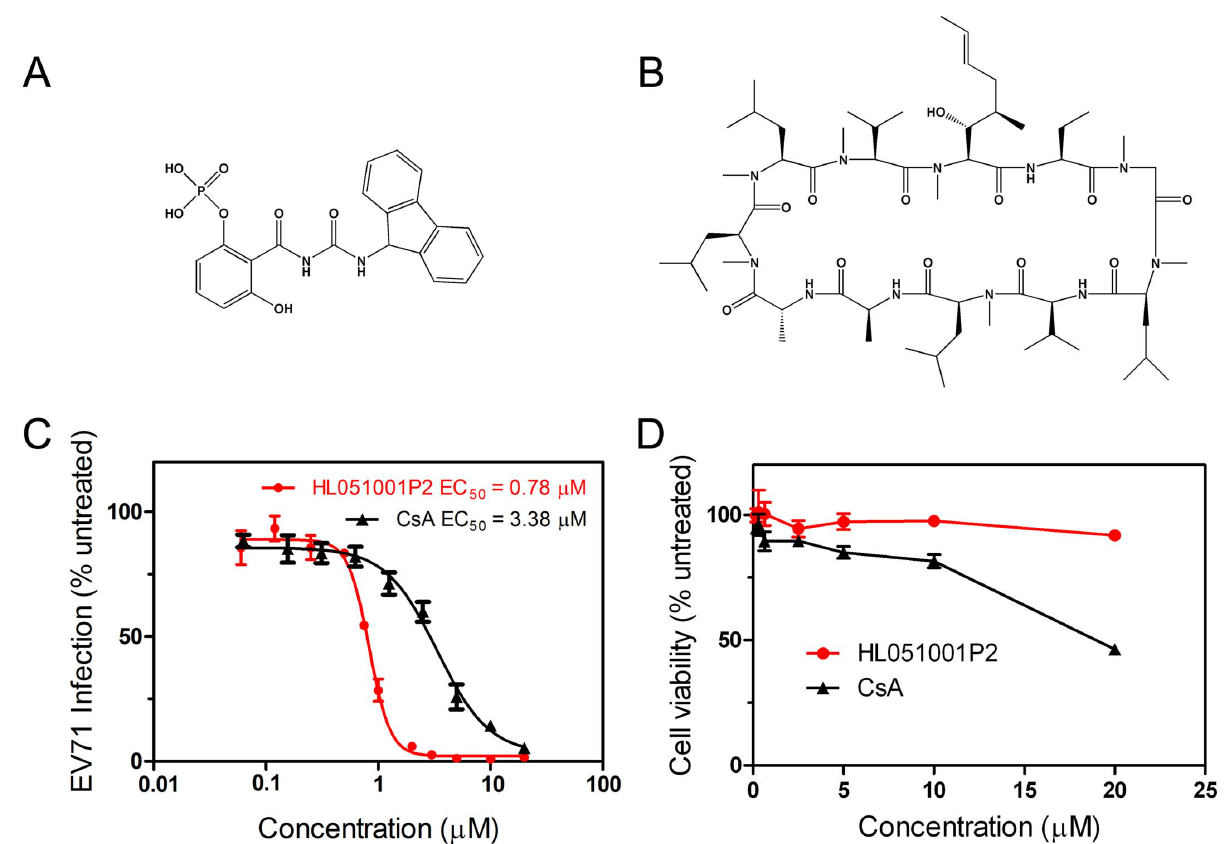
Figure 1. The concentration-dependent reduction of EV71 RNA following treatment with compound HL051001P2 and CsA. Chemical structures of compound HL051001P2 (A) and CsA (B) . After the RD cells were incubated for 6 h with various concentrations of compound HL051001P2 (0.06 to 20 m M for anti-EV71 activity and for cytotoxicity) and CsA (0.06 to 20 m M for anti-EV71 activity and for cytotoxicity), the cells were then infected with EV71 virus at an MOI of 1. (C) The infection of RD cells with EV71 virus in the presence of the compound treatments were quantified by qRT-PCR at 24 hpi, and the data were expressed as the percentage of EV71 RNA from the untreated control cells; the mRNA level of GAPDH was used as an internal control. Each data point represents the average of three replicates. Error bars represent the SEM. (D) To monitor the cytotoxic effects, the viability of the RD cells was determined after compound treatment by using a WST-1 based assay, which was compared with that of the untreated control cells at 24 h post compound treatment. Each data point represents the average of three replicates. The EV71 virus used in these experiments was strain AnHui1.